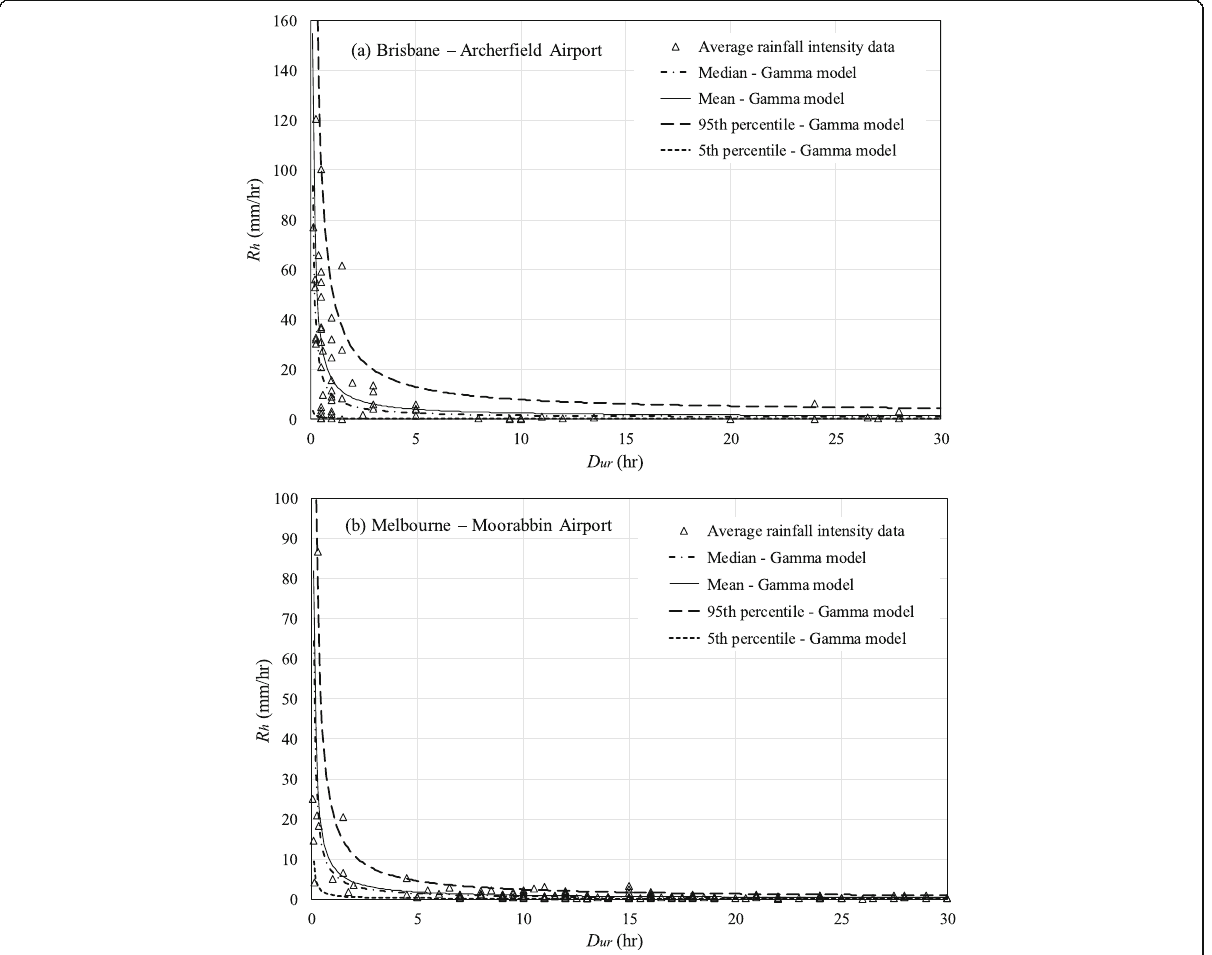
Fig. 4 Average rainfall intensity R h from the observed data and gamma regression model [26]